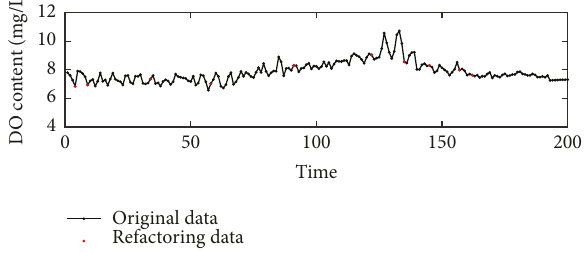
Figure 22: Outlier correction results for DO monitoring